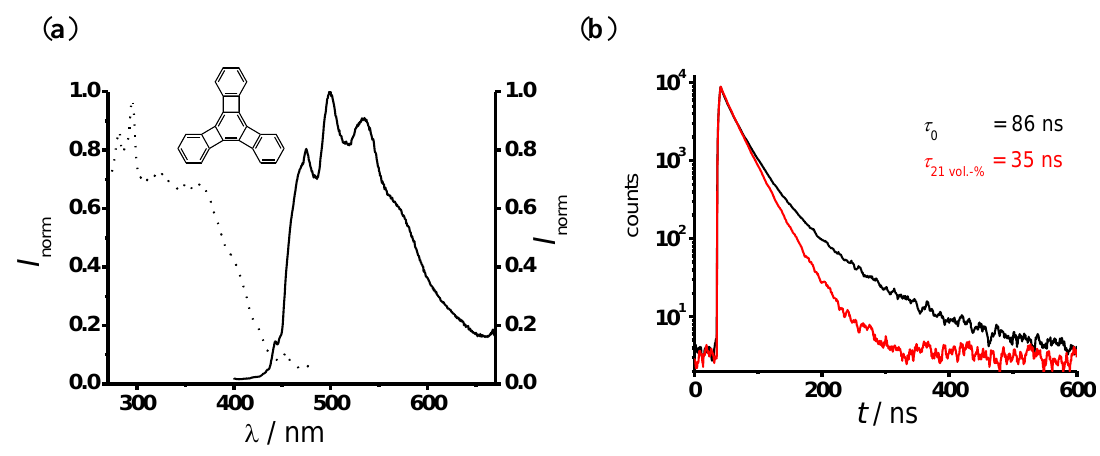
Figure 4. Excitation spectra (dotted line;  = 500 nm) and emission spectra (solid line; em  = 350 nm) of TP in silicone ( a ); fluorescence decay curves at different oxygen ex concentration,  = 86 ns;  = 35 ns ( b 0 21 vol.-%